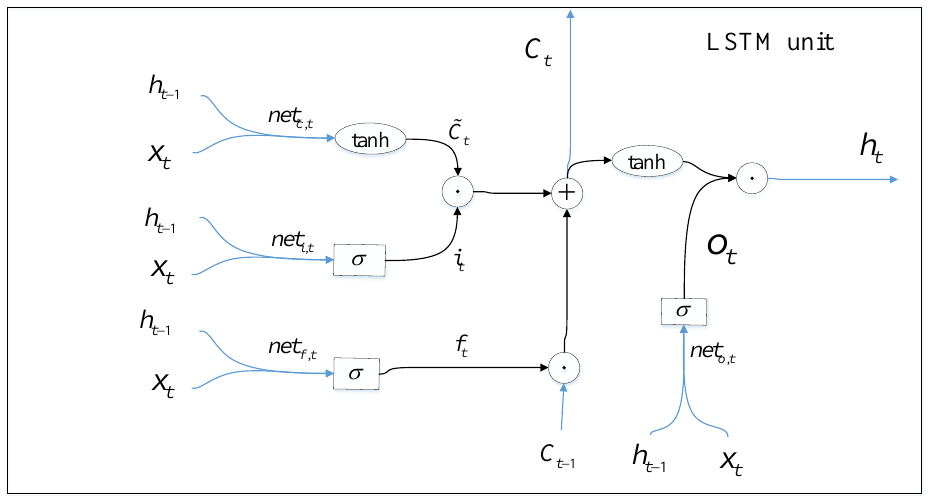
Figure 2. LSTM Figure 2. LSTM unit.